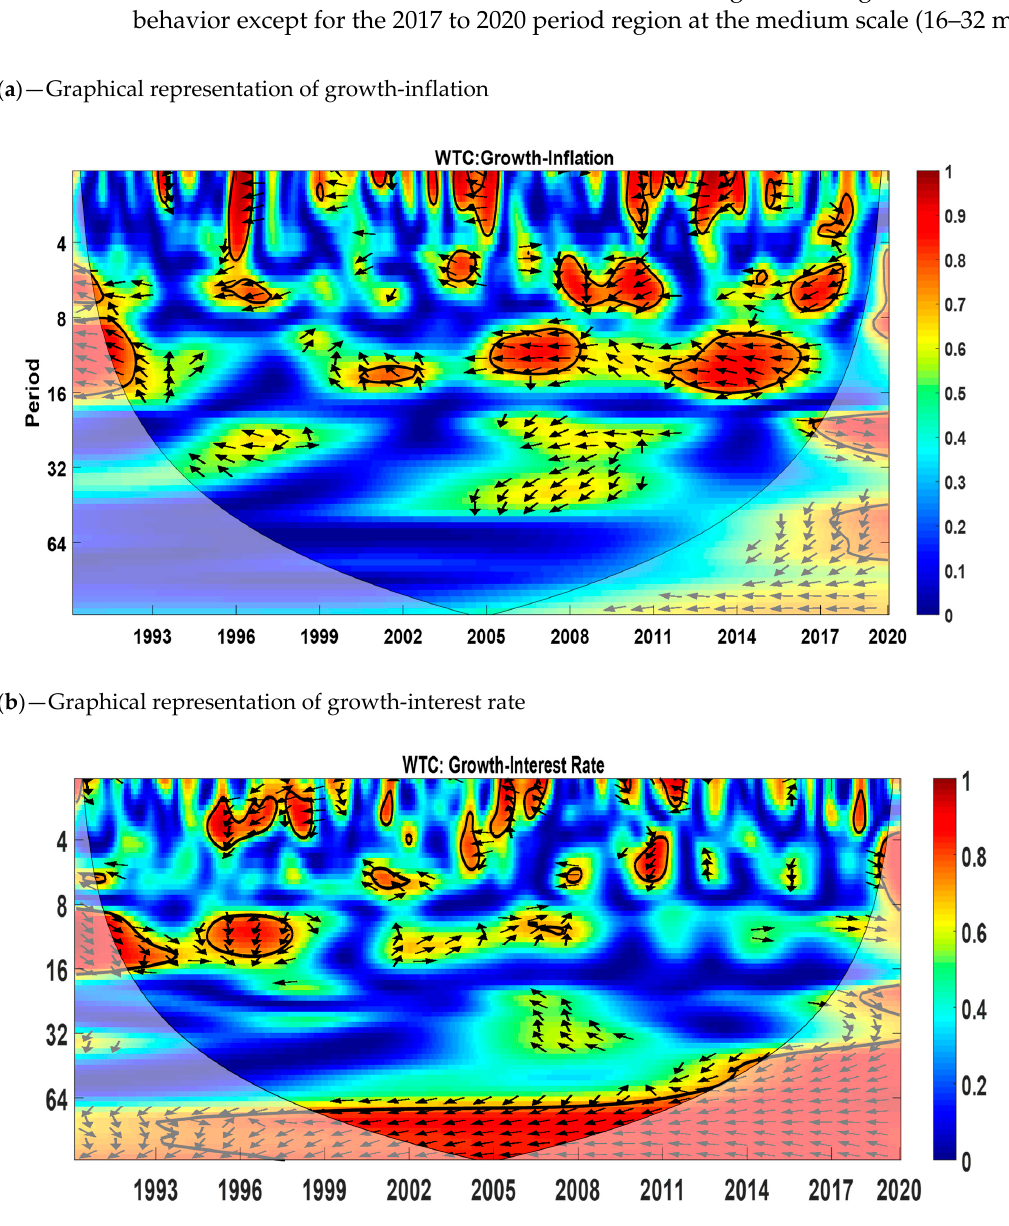
Figure 4. Cross-wavelet coherence. Source: Author’s own contribution. The cross-wavelet coherency for the interest rate and growth is represented by panel (b). Most of the significant regions show that the interest rate and economic growth are out of phase except in the medium run (8 to 16 months) for the time period 1991–1994. The relationship between the interest rate and growth is significant in the medium run (8 to 16 months) and long run (64 to 128 months). The significant regions in the short